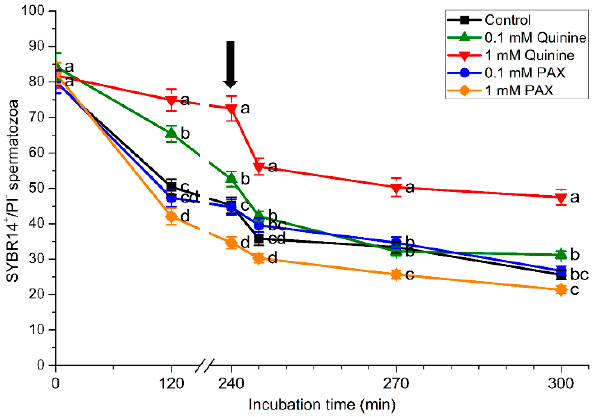
Figure 1. Percentages of spermatozoa with an intact plasma membrane (SYBR14 + /PI − ) during in vitro capacitation and progesterone-induced acrosomal exocytosis (300 min) in the control and treatments containing 0.1 mM quinine, 1 mM quinine, 0.1 mM paxilline (PAX), or 1 mM PAX. Black arrow indicates the time at which 10 μ g/mL progesterone was added to induce acrosomal exocytosis (i.e., 240 min). Different letters (a–d) indicate significant ( p < 0.05) differences between treatments at a given time point. Data are shown as mean ± SEM for 15 independent experiments.